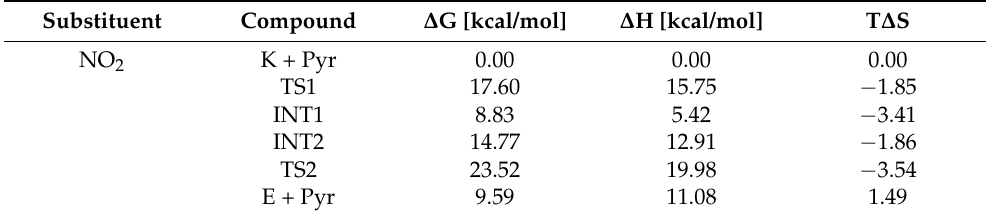
Table 7. Relative enthalpies, entropies, and Gibbs energies (kcal/mol) at 298 K for the station- ary points involved in the pirydyne catalyzed tautomeric reaction of antralin with two different substituent (in gas